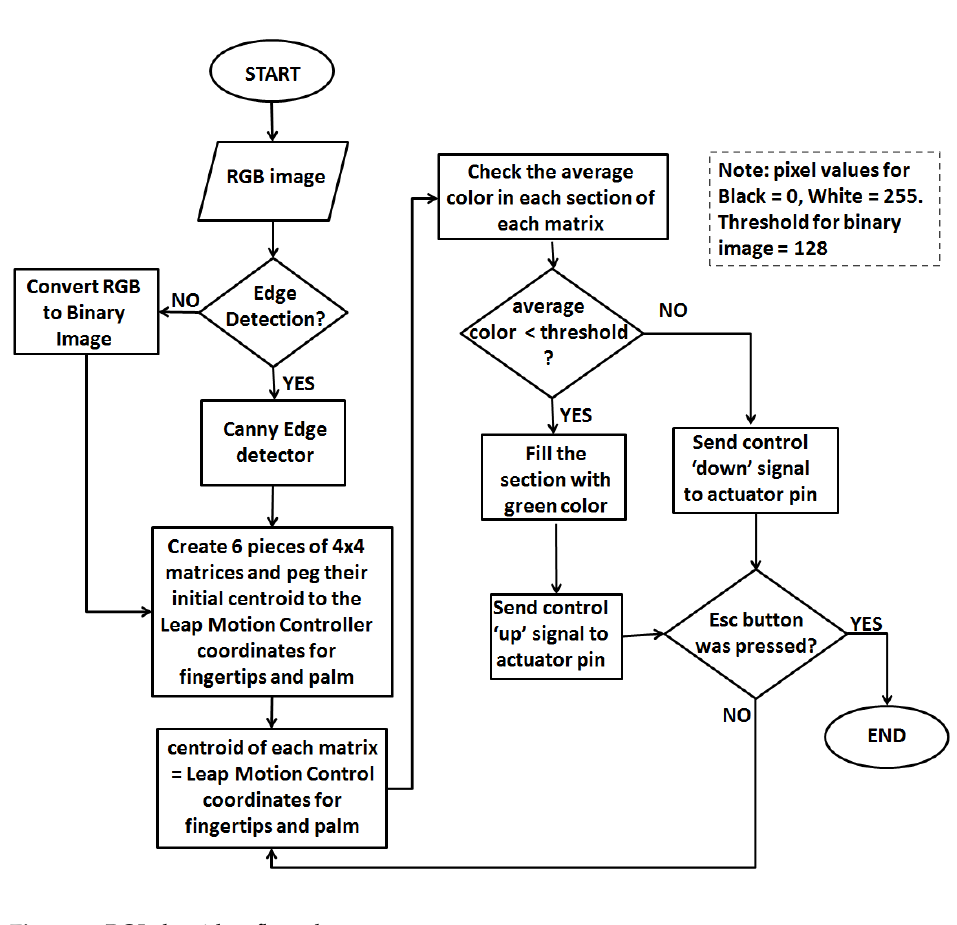
Figure 6. ROI algorithm flow chart.